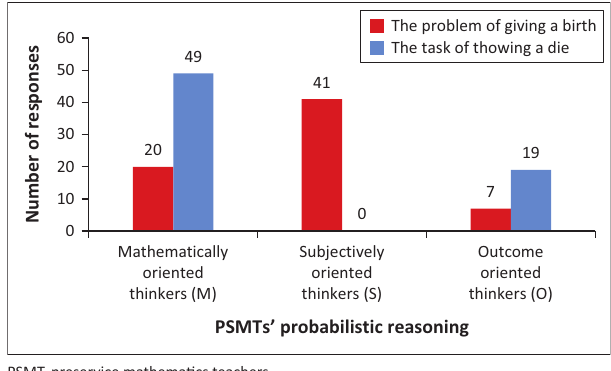
FIGURE 2: PSMTs’ probabilistic reasoning manners in two different